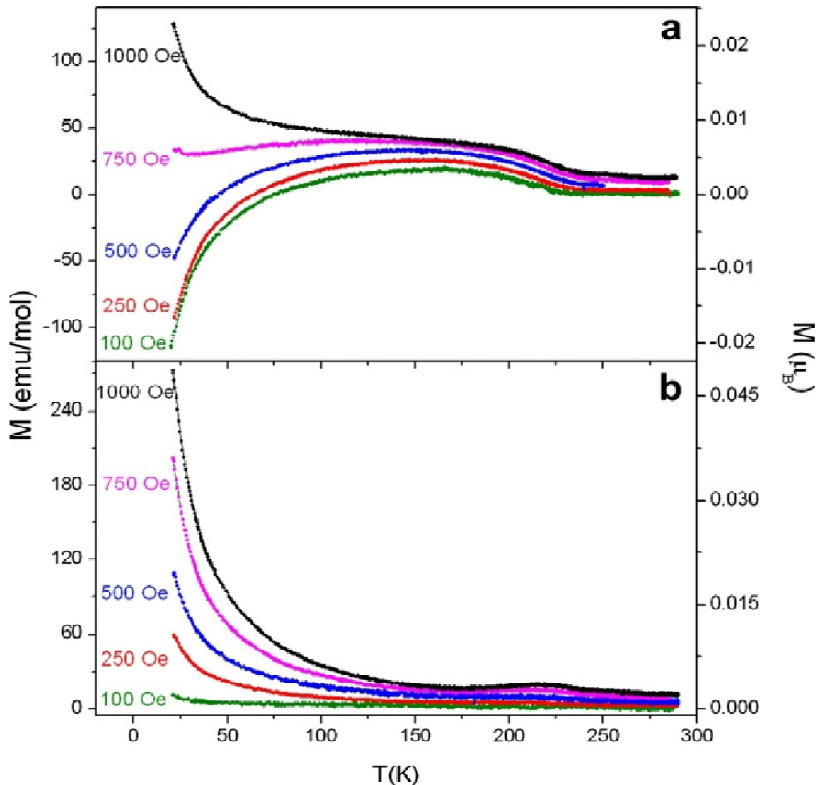
Fig. 5. Temperature dependent magnetization curves recorded under different external magnetic fields in (a) FC mode and (b) ZFC mode. Reproduced from [26] with permission from